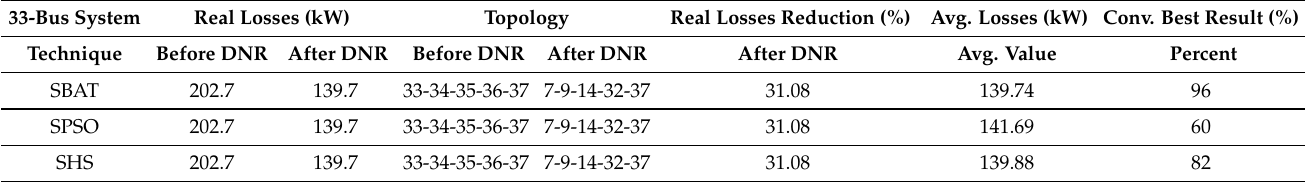
Table 4. Results found for the 33-bus and 37-branch balanced system (fixed